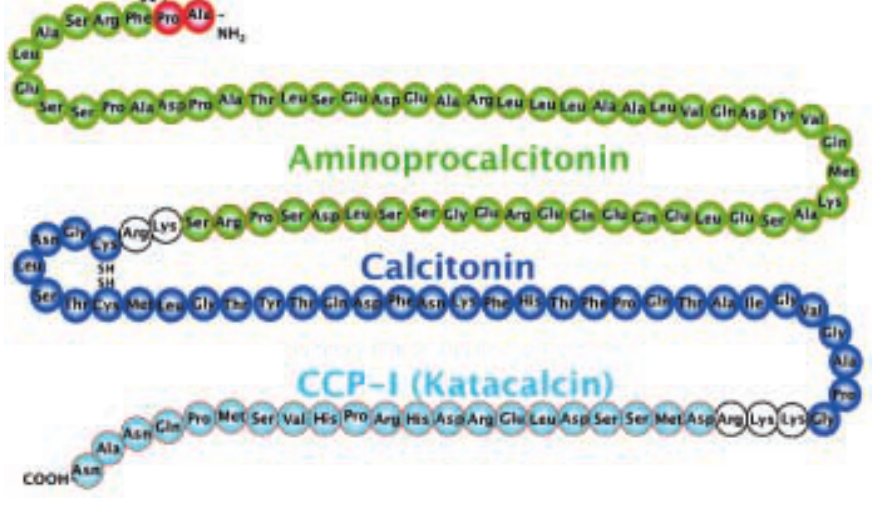
Schematic illustration of human procalcitonin. Procalcitonin and its constituent peptides, which are found in the free form in normal human serum. Initially, procalcitonin consisting of 116 aminoacids is secreted. Due to rapid cleavage by dipepti- dases, 114 aminoacid long procalcitonin is found in the circulation. Additional cleaving leads to circulating aminoprocalci- tonin, immature calcitonin and calcitonin carboxypeptide-I (CCP-I), previously known as katacalcin. In sepsis, these peptides are variably increased, often to huge levels due to ubiquitous expression and secretion. However, in this condition, serum levels of mature calcitonin, which is only produced by thyroidal c-cells, remain normal or are only slightly increased.